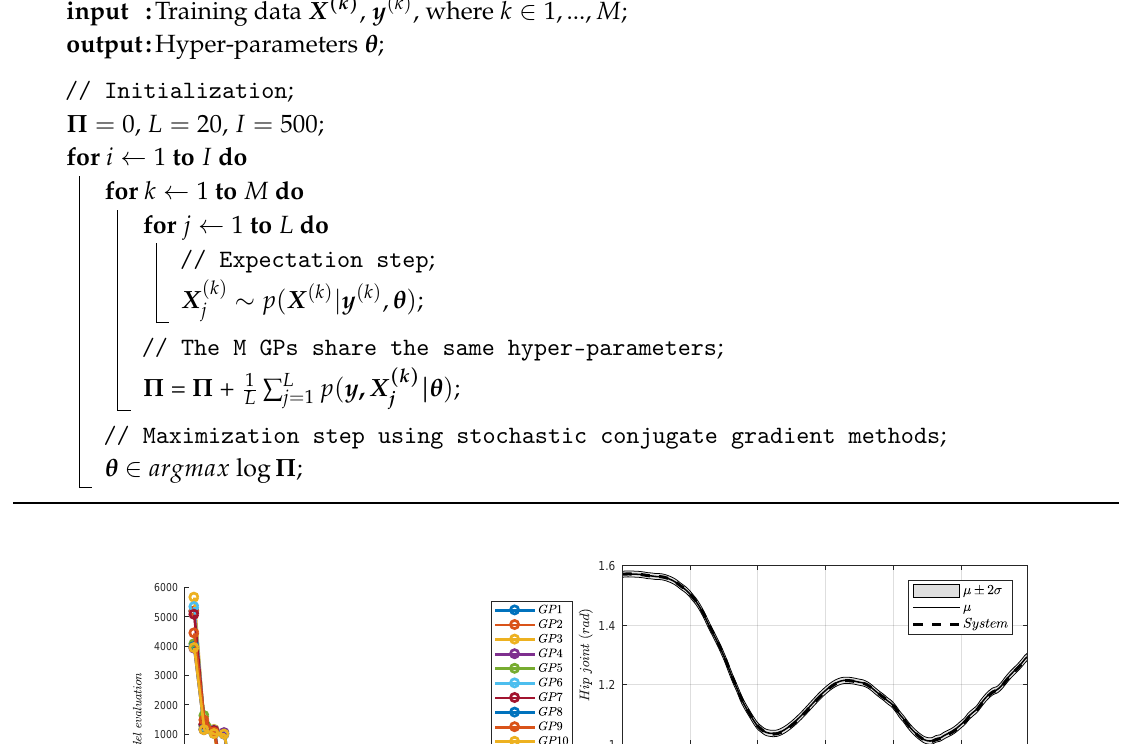
Algorithm 1: Calculate Hyper-Parameters Value with Monte Carlo Expectation Maximization